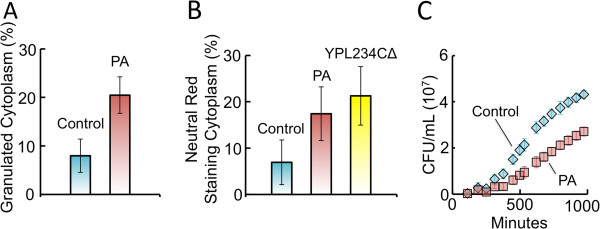
Expression of the PA incompatibility domain at low-levels in yeast results in aberrant phenotypes. A) Phase contrast microscopy revealed that PA-expressing yeast exhibit significantly more cells having a granulated cytoplasm compared to control strain (P = 0.007). Cytoplasmic granulation is a key feature of heterokaryon incompatibility in filamentous fungi. B) Significantly more PA-expressing yeast cells exhibit cytoplasmic acidification in comparison to control strain (P = 0.015) based on neutral red staining. The frequency of PA-expressing cells that exhibited an acidified cytoplasm did not differ from that of the vATPase-defective strain, YPL234C. For both A and B, error bars represent standard deviation based on 5 biological replicates where a minimum of 100 cells were counted. C) PA-expressing yeast had a slower growth rate in YPD compared to the control strain (P < 0.001). Growth was monitored by using a microplate reader and CFU was calculated from a standard curve of CFU versus OD600 (not shown). Error bars represent standard deviation based on three biological replicates.